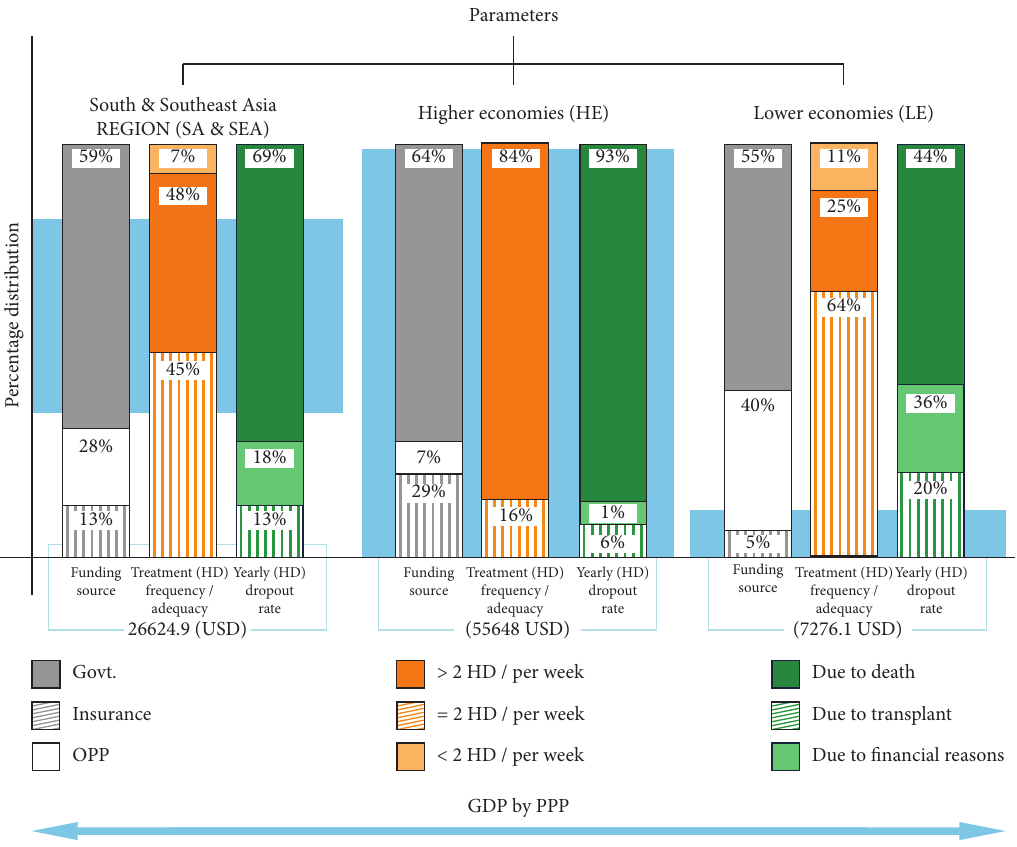
Figure 3: Impact of GDP on funding source, treatment adequacy, and yearly